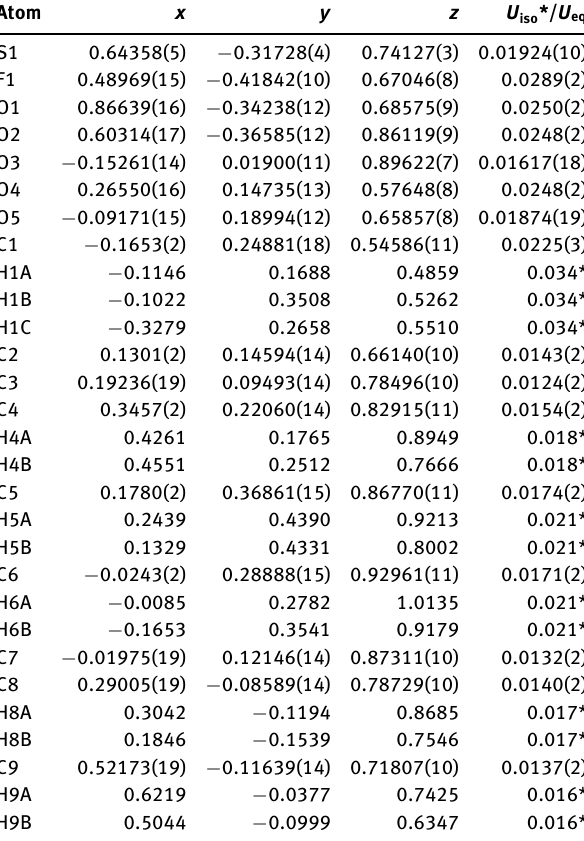
Table 2: Fractional atomic coordinates and isotropic or equivalent isotropic displacement parameters (Å 2